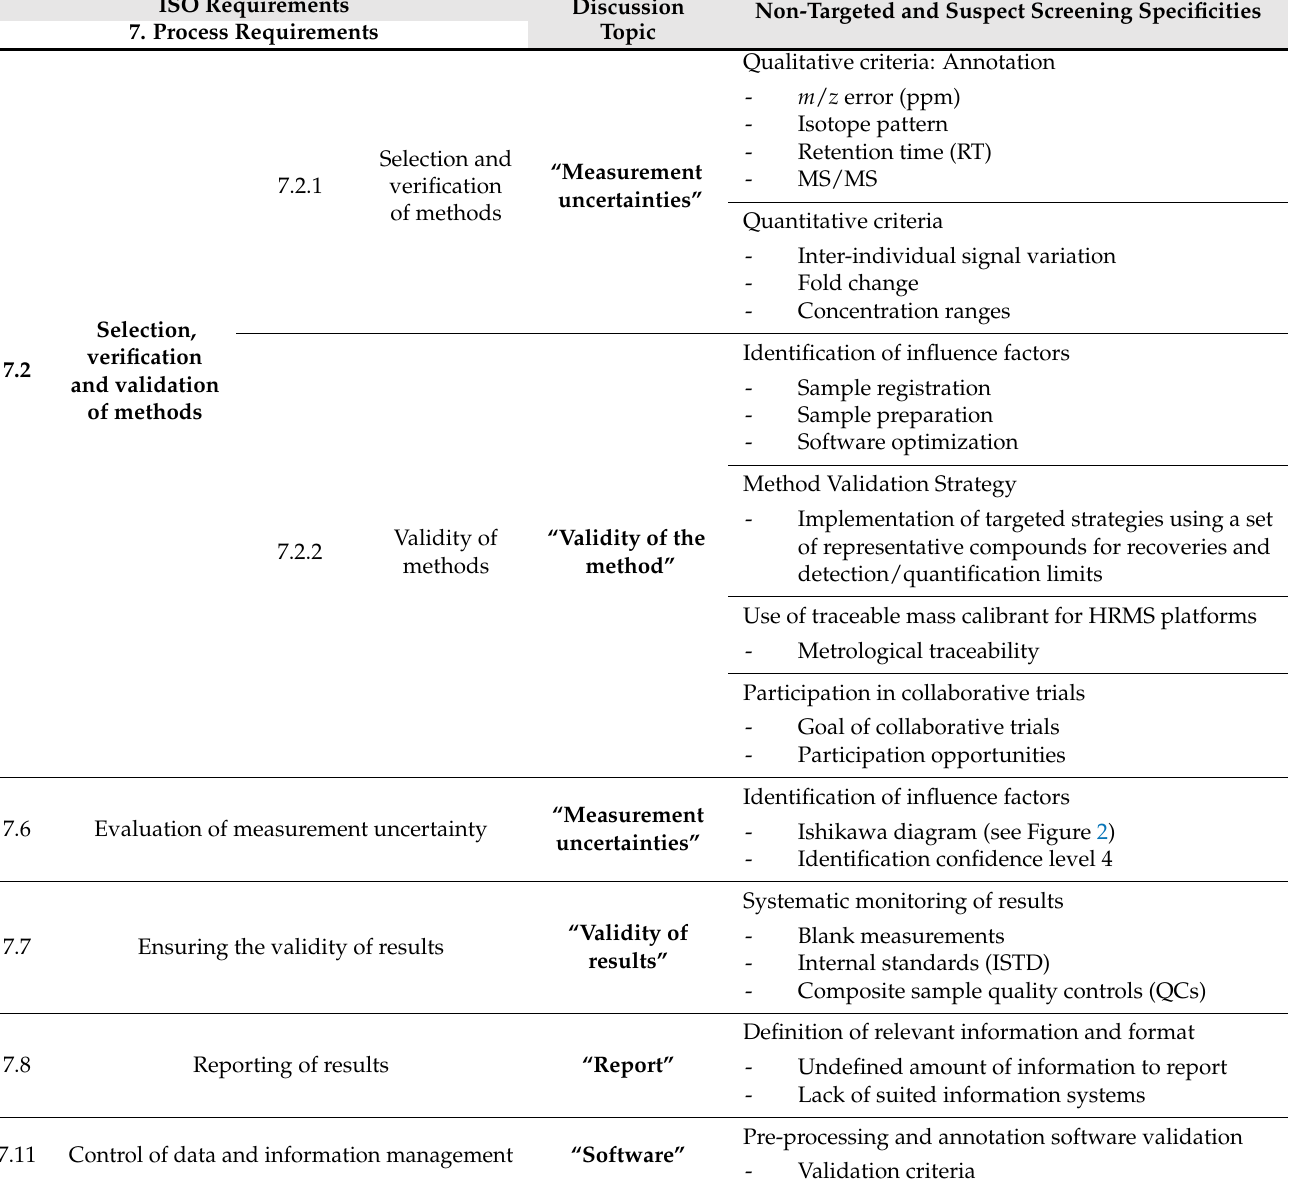
Table 2. Classification of ISO/IEC 17025 adaptable requirements for non-targeted/suspect screening methodologies. ISO